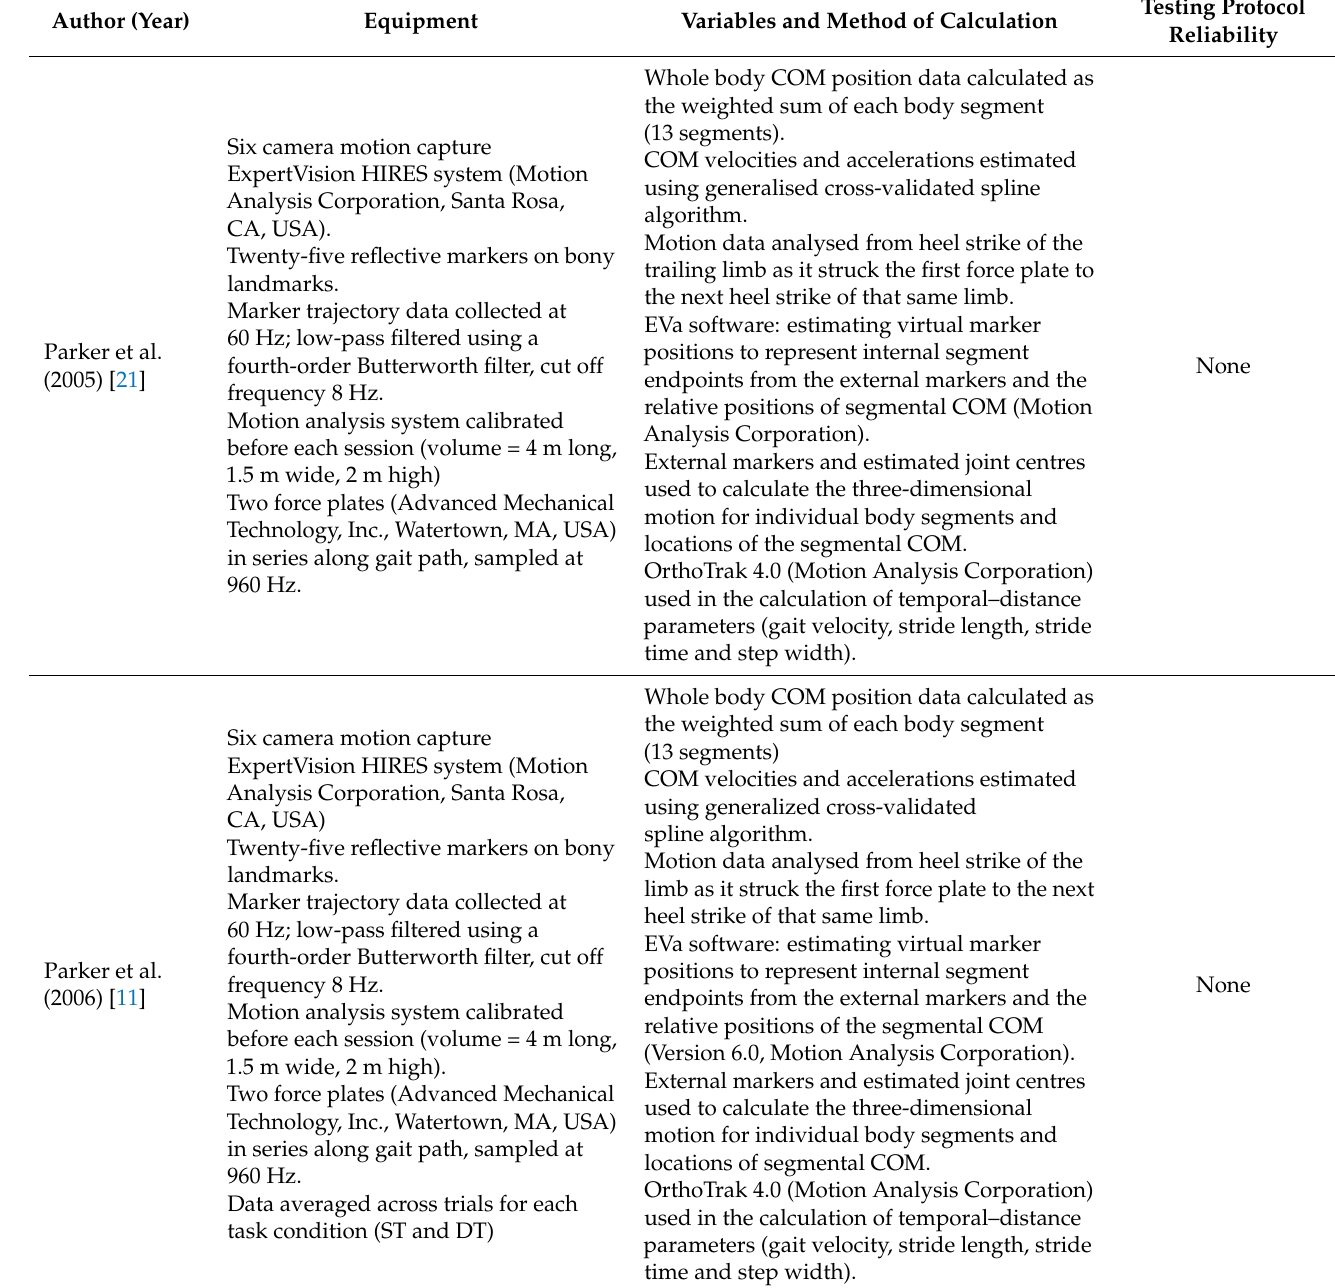
Table 2. Equipment and technologies utilised in reviewed